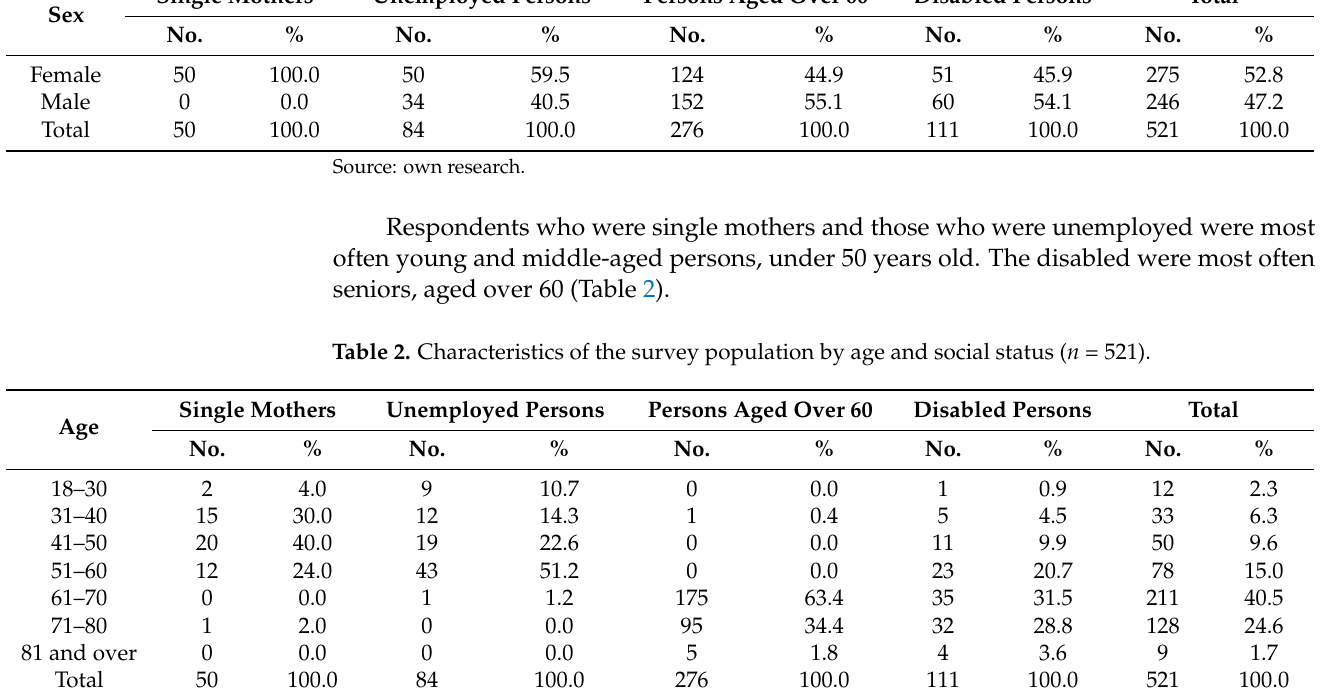
Table 2. Characteristics of the survey population by age and social status ( n = 521).